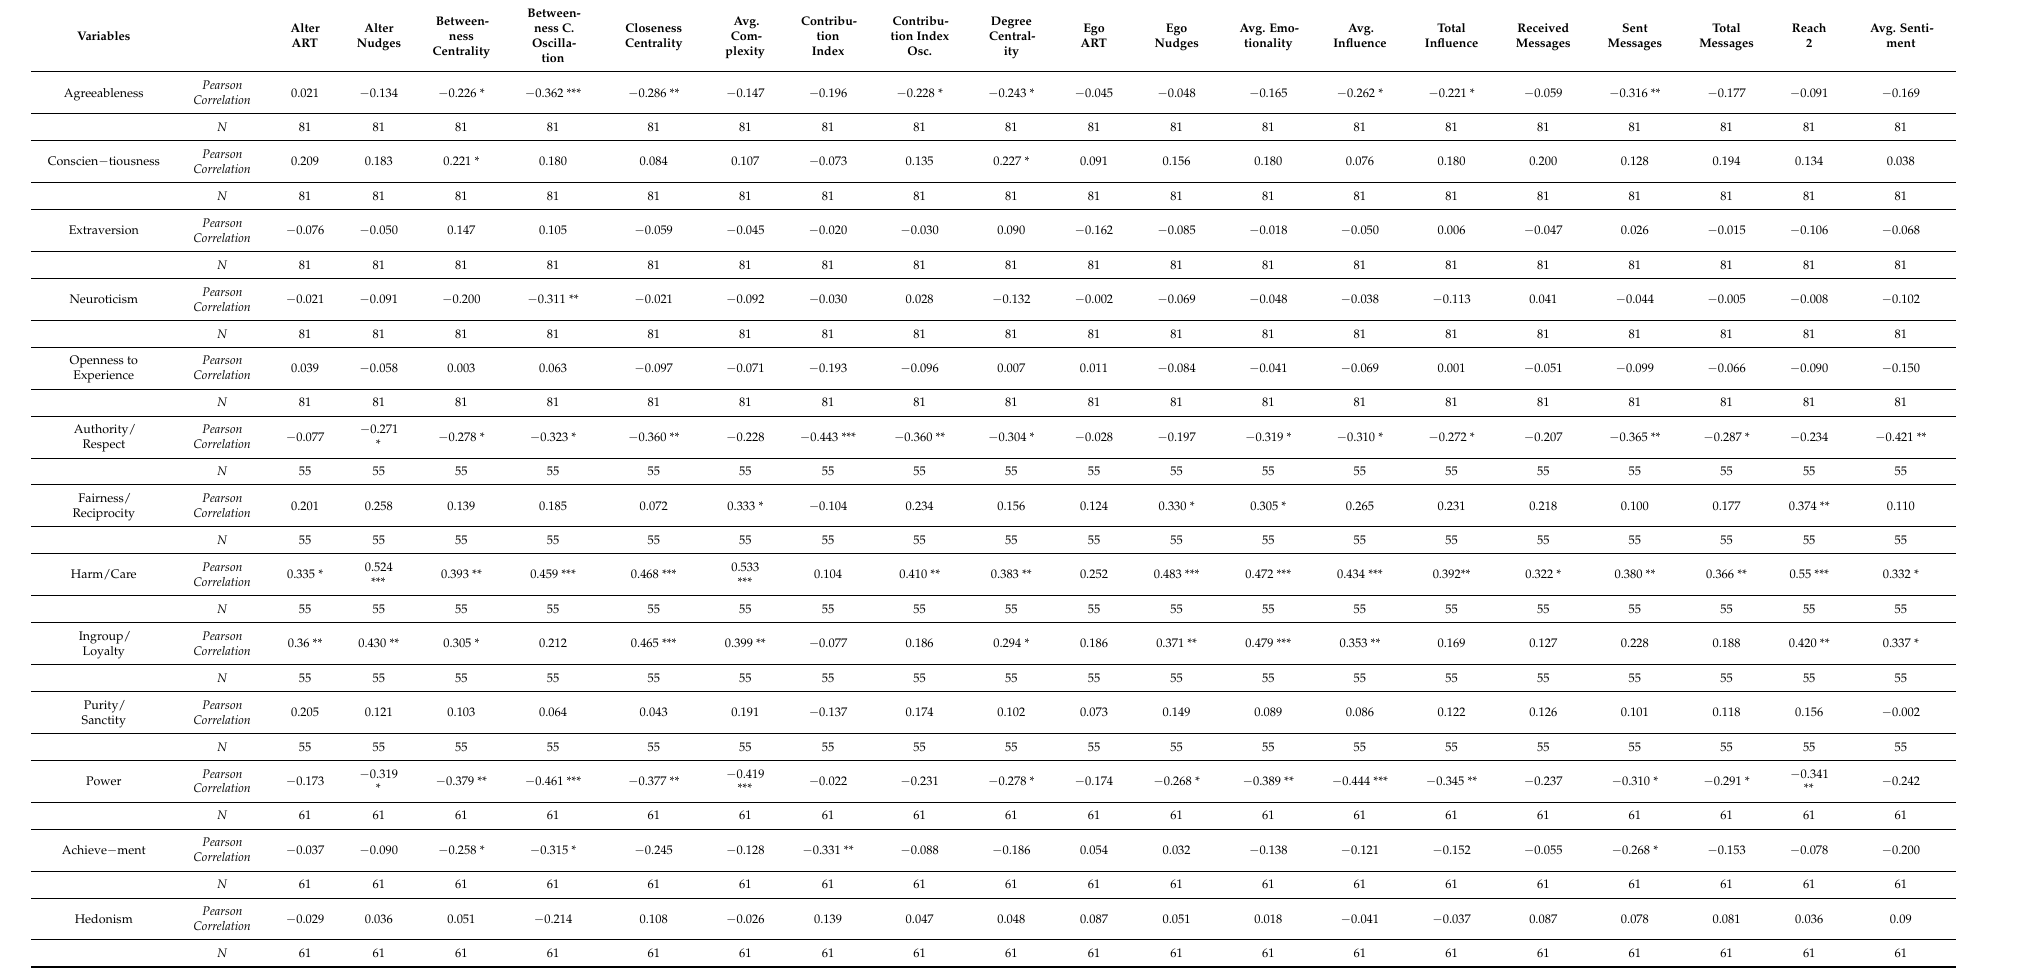
Table A1. Pearson Correlation between Personal/Moral Values and Honest